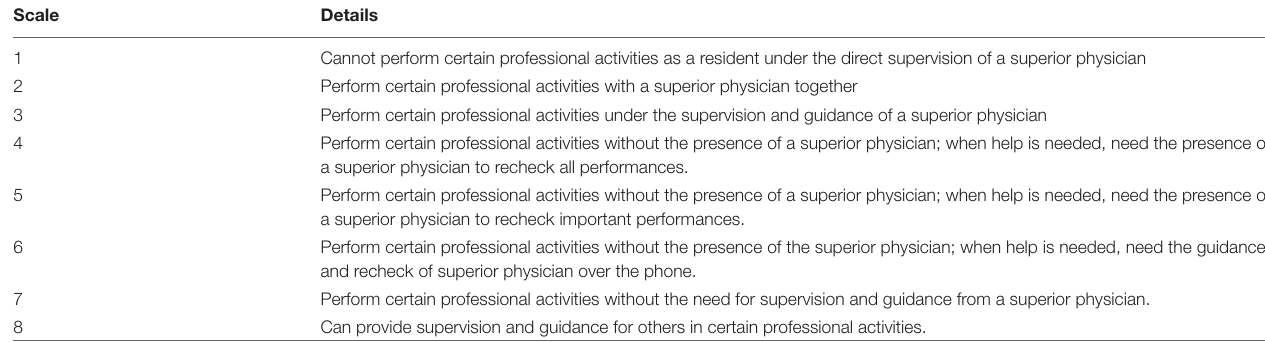
TABLE 2 | Eight entrustable levels of each entrustable professional activity (EPA).